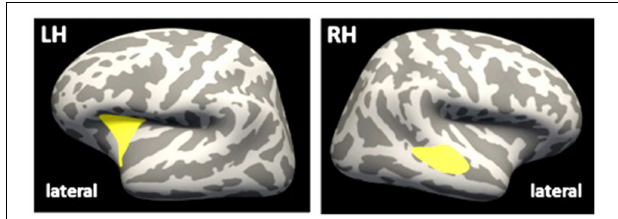
FIGURE 2 | Differences in CT between groups. Inflated brain, lateral view. Yellow clusters indicate significant lower CT in mTBI group, as compared to control group. LH, left hemisphere; RH, right hemisphere; CT, cortical thickness.